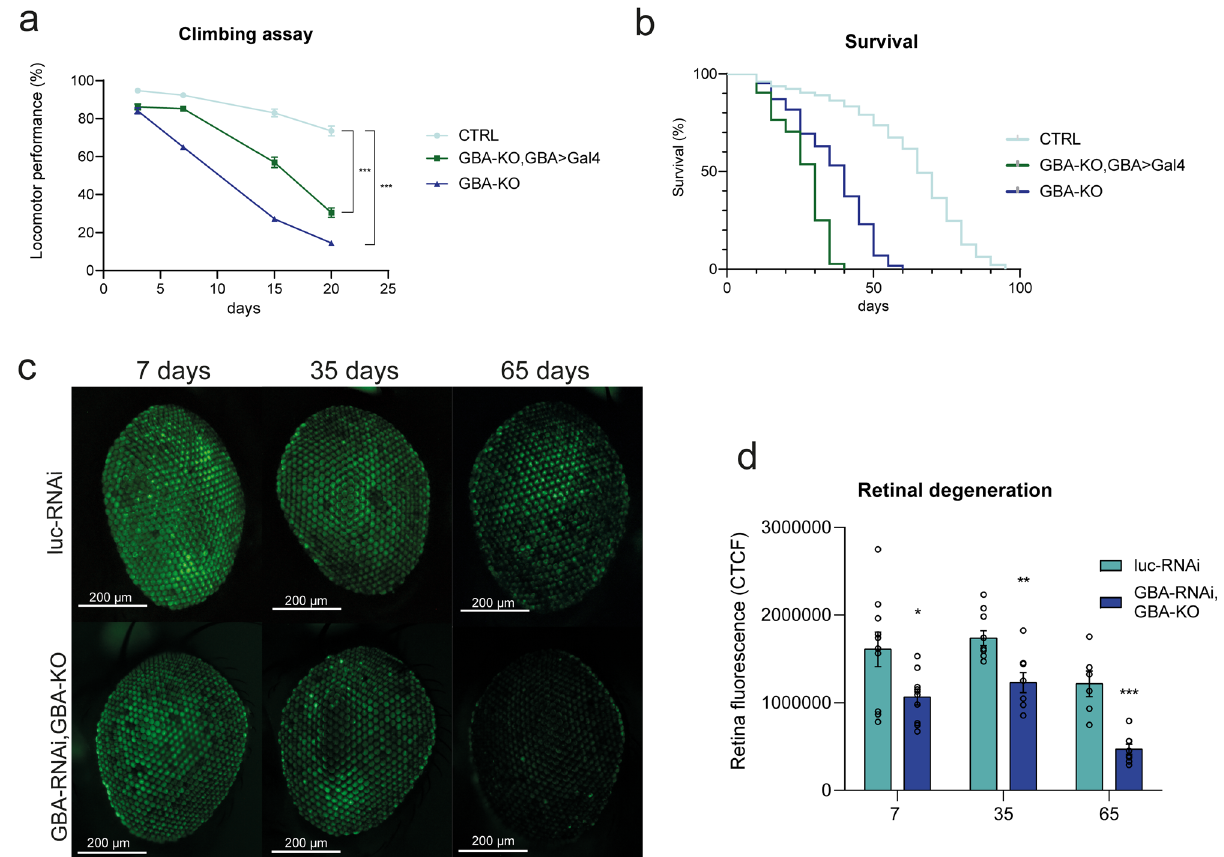
Fig. 1 GCase de fi ciency causes retinal degeneration and behavioral de fi cits associated to neurodegeneration. a GBA-LoF models (GBA-KO and GBA- KO, GBA > Gal4) show a signi fi cant impairment of climbing abilities. Climbing assay was performed on 150 fl ies at 3, 7, 15, and 20 days. w 1118 are used as control fl ies (CTRL). Two ways ANOVA test and unpaired t -test comparing CTRL and GBA-KO at the four time points resulted in statistical signi fi cance (*** p < 0.001). b GBA-LoF models show heavily reduced lifespan. Overall survival was calculated with the Kaplan – Meyer curve on 150 fl ies for each genotype. Log rank p value <0.001. c Representative Z-stack acquisition of adult eyes expressing luc -RNAi, used as control, or GBA-RNAi, GBA-KO